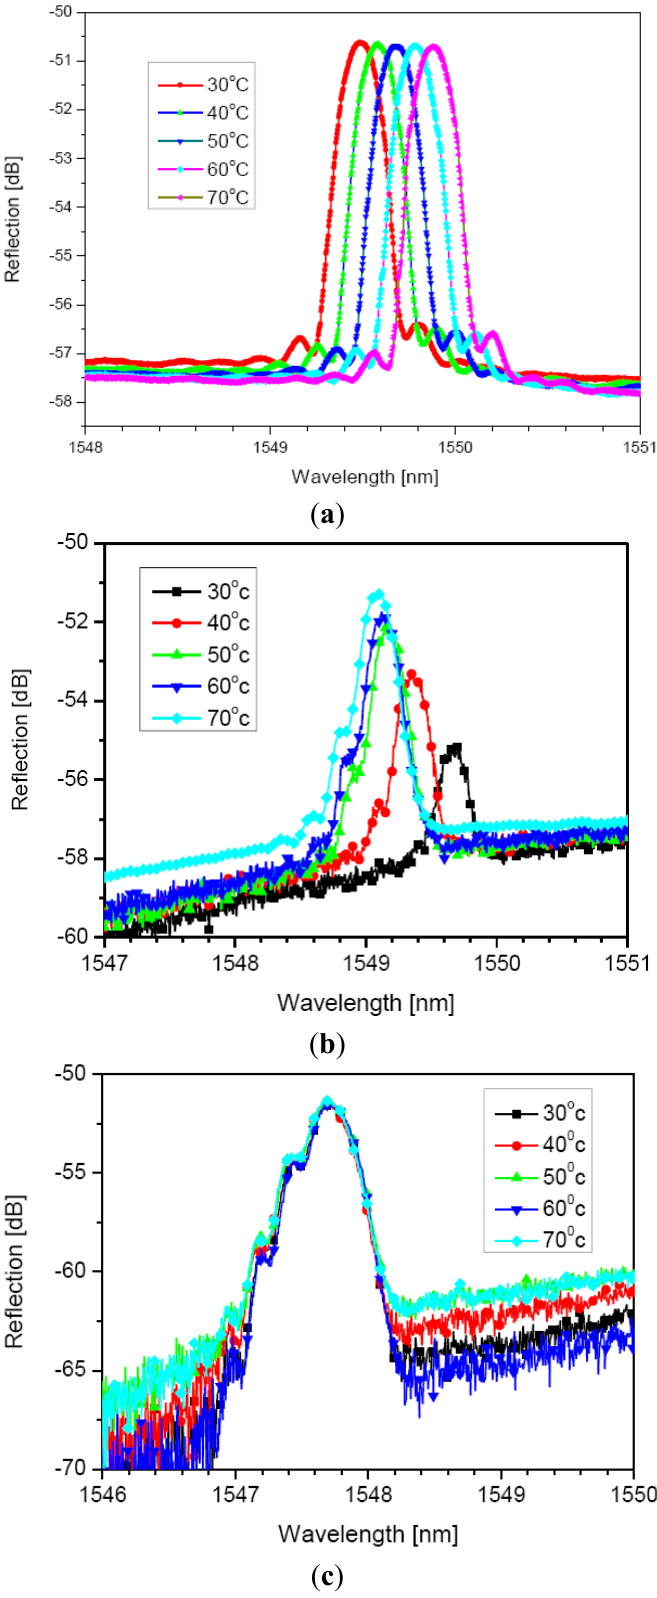
Figure 5. Spectral responses as a function of temperature of ( a ) non-cladding-etched FBG; ( b ) cladding-etched FBG in the liquid mixture of water (7%) and glycerin (93%); and ( c ) cladding-etched FBG in the liquid mixture of water (50%) and glycerin